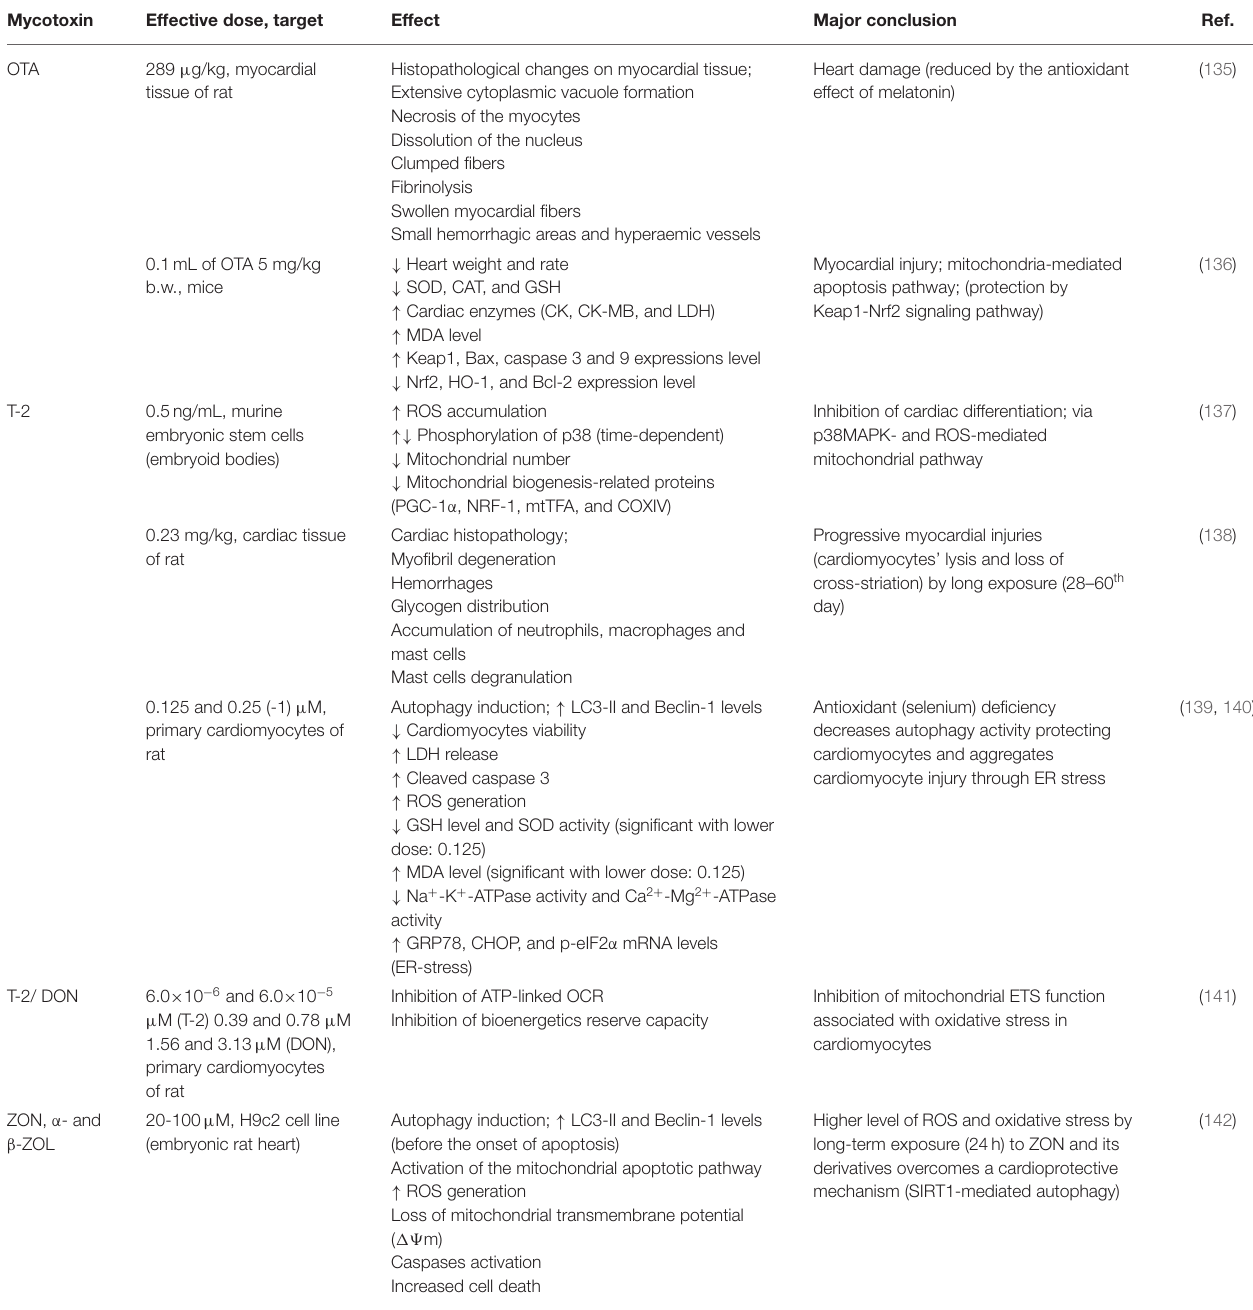
TABLE 4 | The cardiotoxicity of